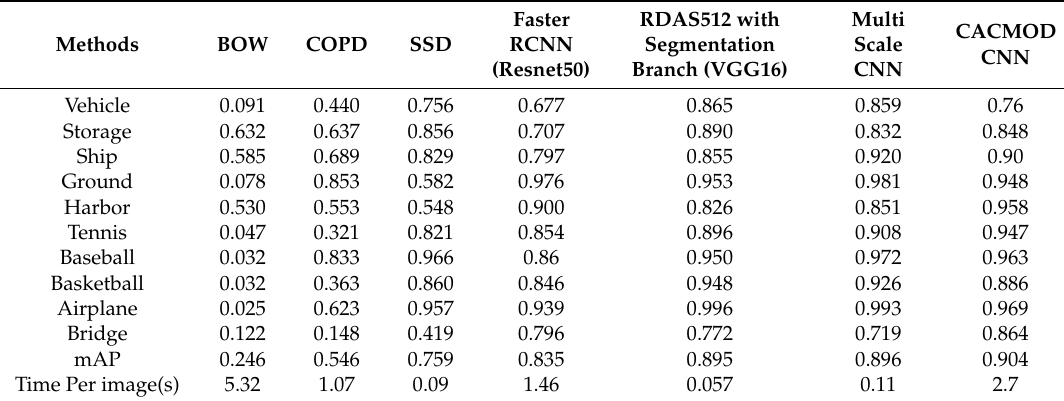
Table 2. The AP values of the seven baseline